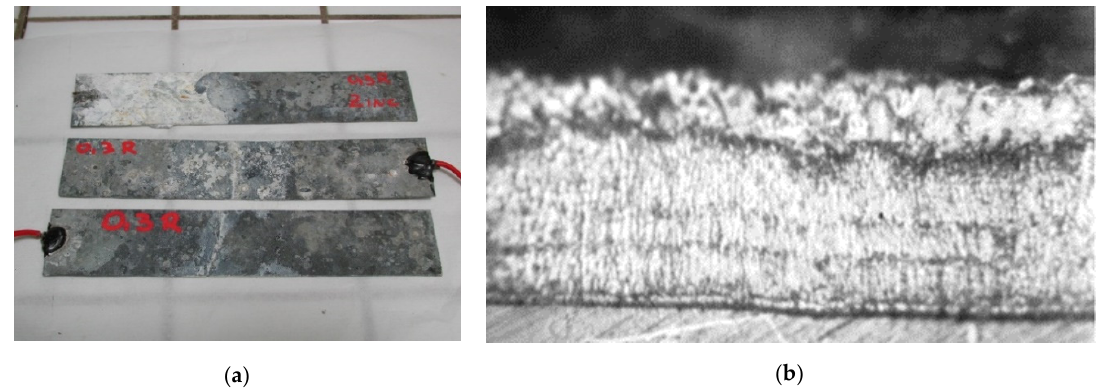
Figure 11. Visual obs. ( a ) and metallographic cross section ( b ) of a galvanized steel plate in Rec-0.3